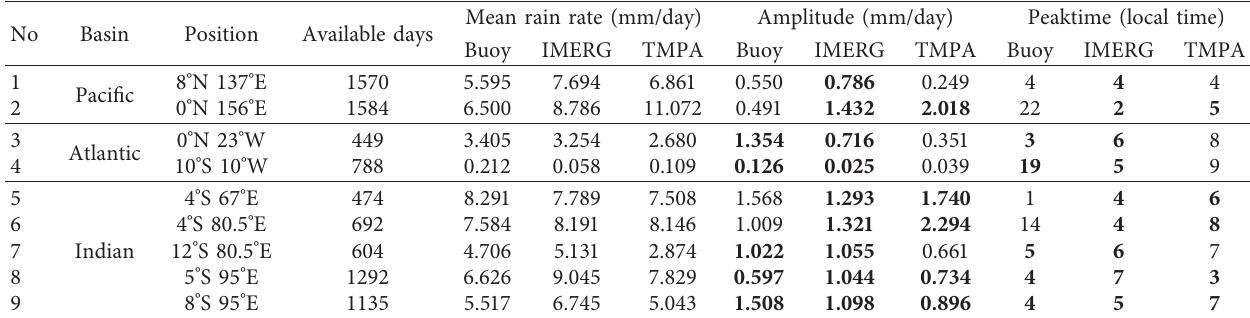
Table 1: Mean rain rates, diurnal precipitation amplitudes and peak times for ninxe buoys and for 5 ° × 5 ° area-averaged IMERG and TMPA data. The numbers in bold indicate the diurnal signals were detected at the 90% confidence level.